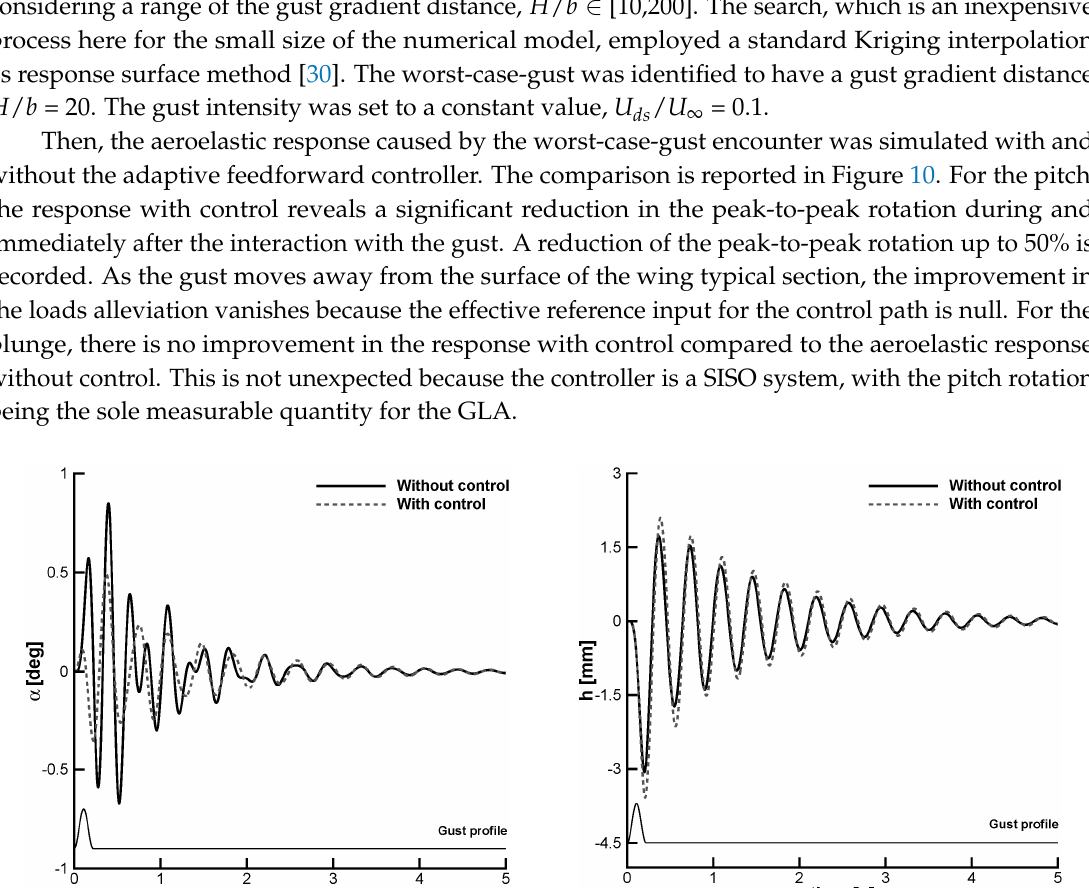
( b ) Samples of weight coefficients Figure 11. Aeroelastic response with control corresponding to Figure 10: ( a ) Commanded rotation of the trailing-edge flap; ( b ) Three samples (out of 20) of the weight coefficients of the controller.